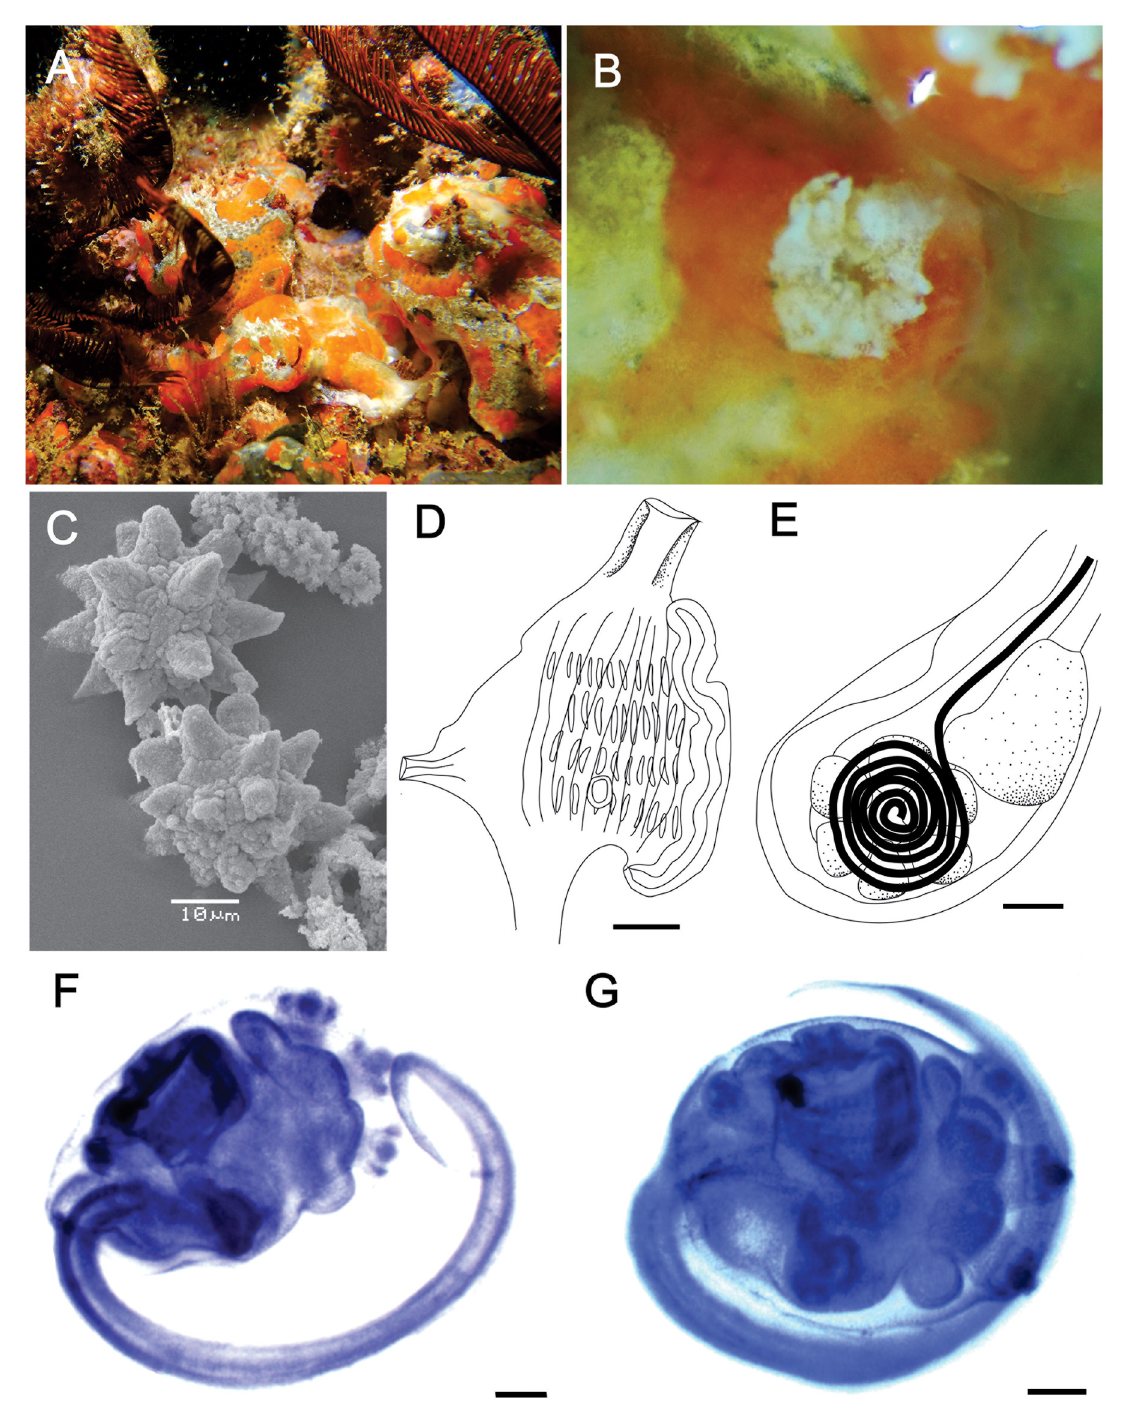
Fig. 1. Leptoclinides coronatus sp. nov . , holotype (DZUP LEP-018). A . Colony in situ . B . Detail of the cloaca with lobes. C . Spicules. D . Thorax. E . Abdomen. F–G . Larvae in different stages in the same colony. Scale bars: D–G = 0.1